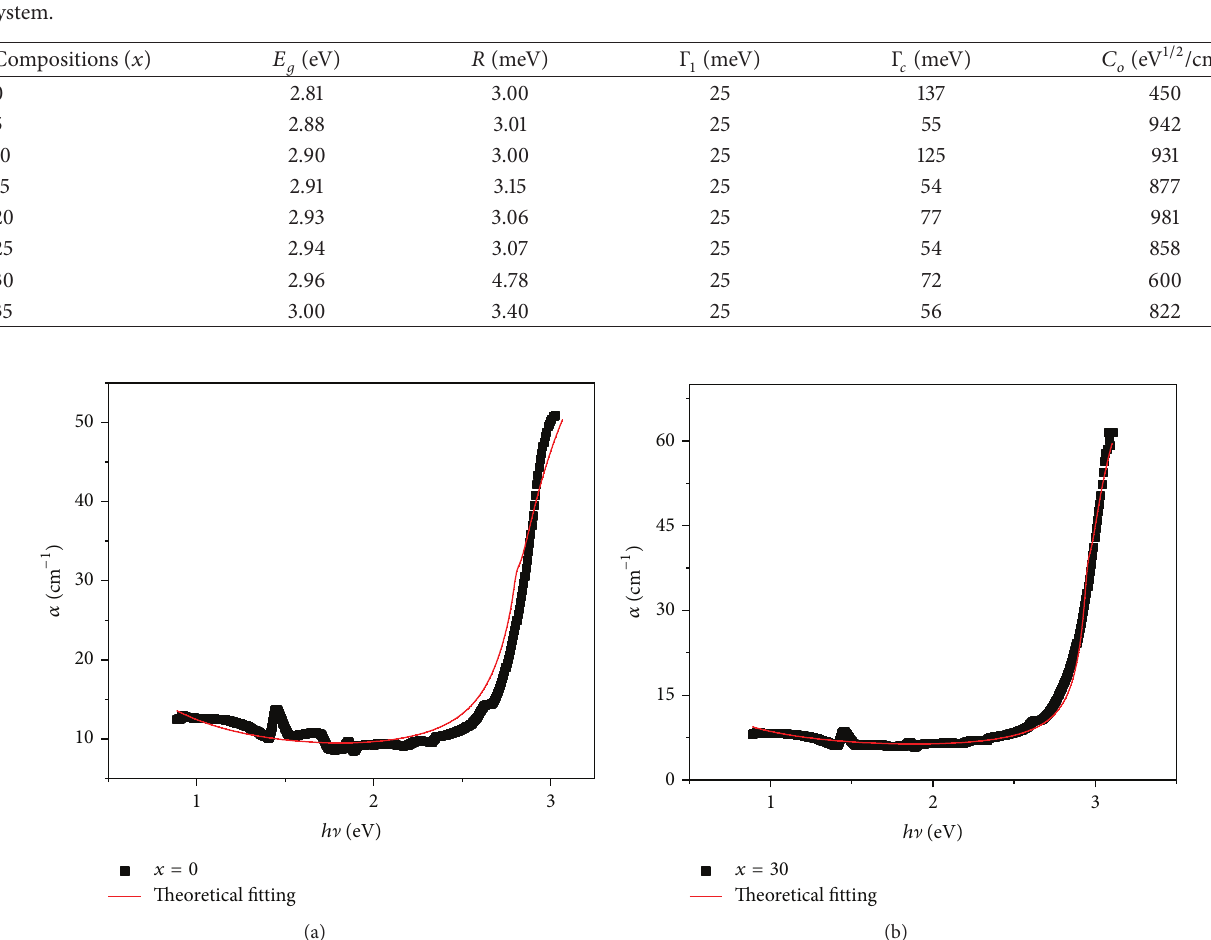
Figure 3: Fitting of absorption spectra using Hydrogenic Excitonic Model of 40SiO 2 ⋅ 𝑥 ZnO ⋅ ( 60 − 𝑥 )Bi 2 O 3 glass system (a) for 𝑥 = 0 , (b) for 𝑥 = 30